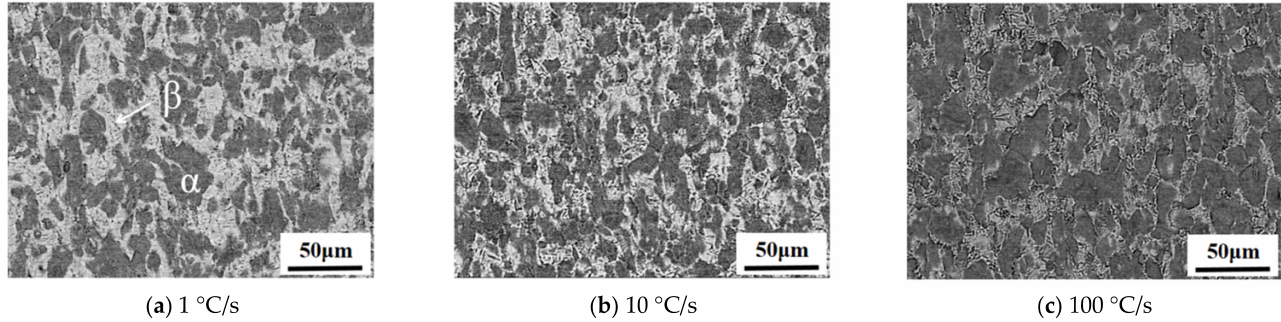
Figure 8. SEM observation of the α and β phases at different heating rates and a constant forming temperature of 900 ◦